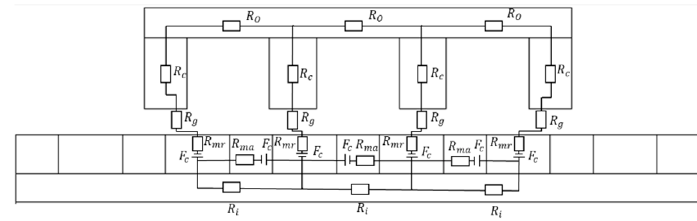
Figure 1. PMLG’s structure.